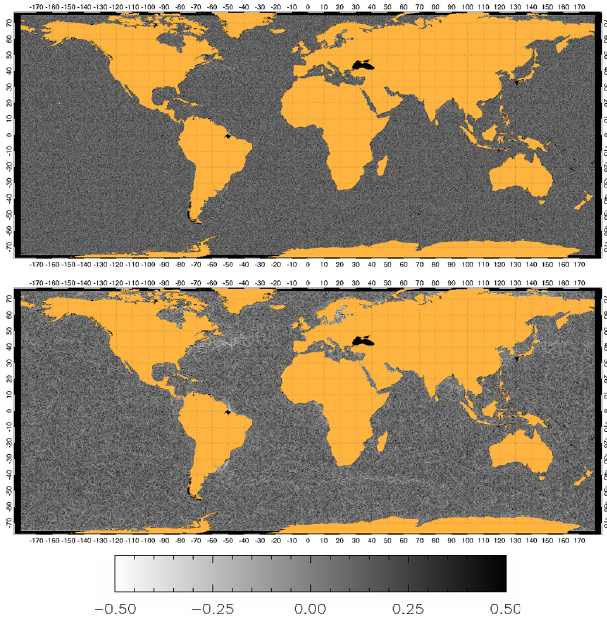
Fig. 12. Top: Singularity exponents associated with SSS after noise of unity amplitude and β = 2. Bottom: Singularity exponents de- rived from the fused SSS map.